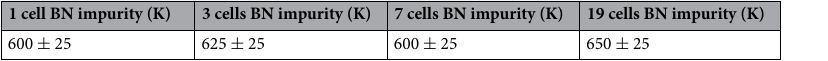
1 cell BN impurity (K)